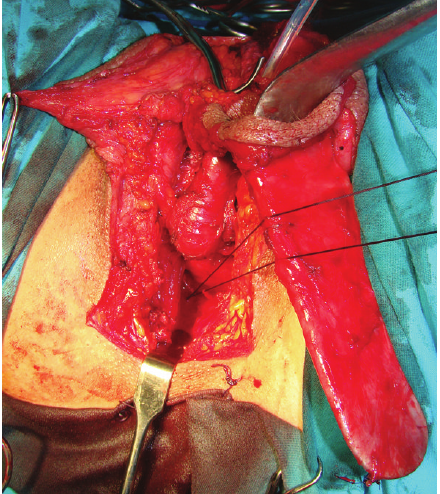
Figure 4: Removal of the corpora cavernosa deeply to their attachments on the pubic bones.